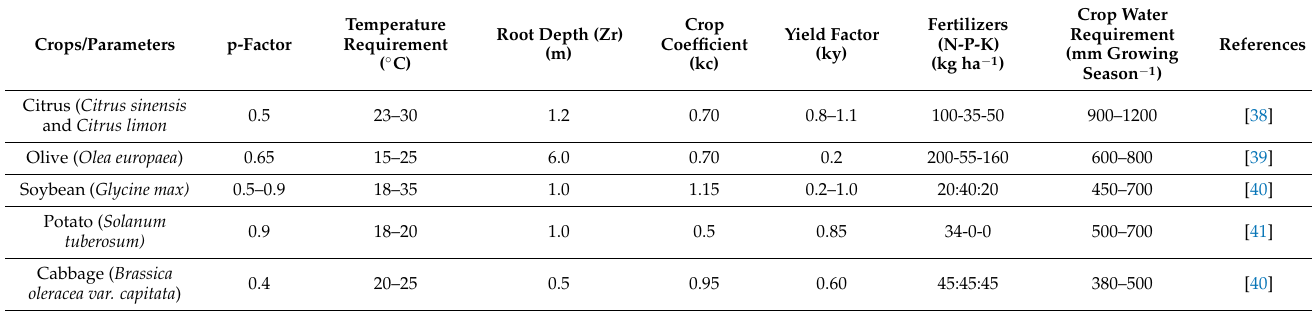
Table 1. Crop database of different crops and their important